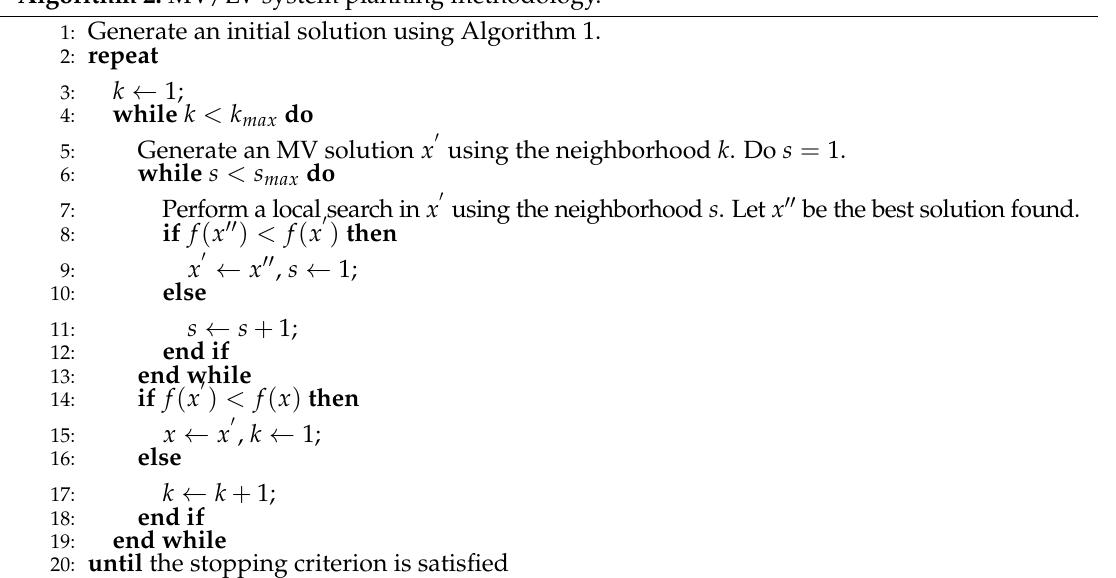
Algorithm 2: MV/LV system planning methodology.